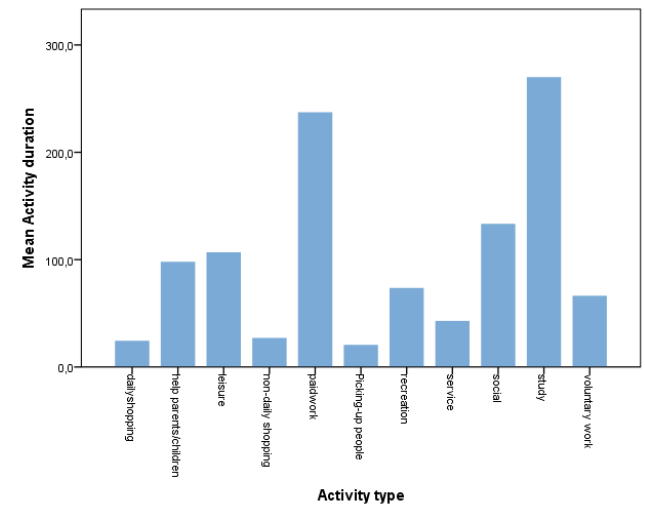
Figure 2. Average duration of different